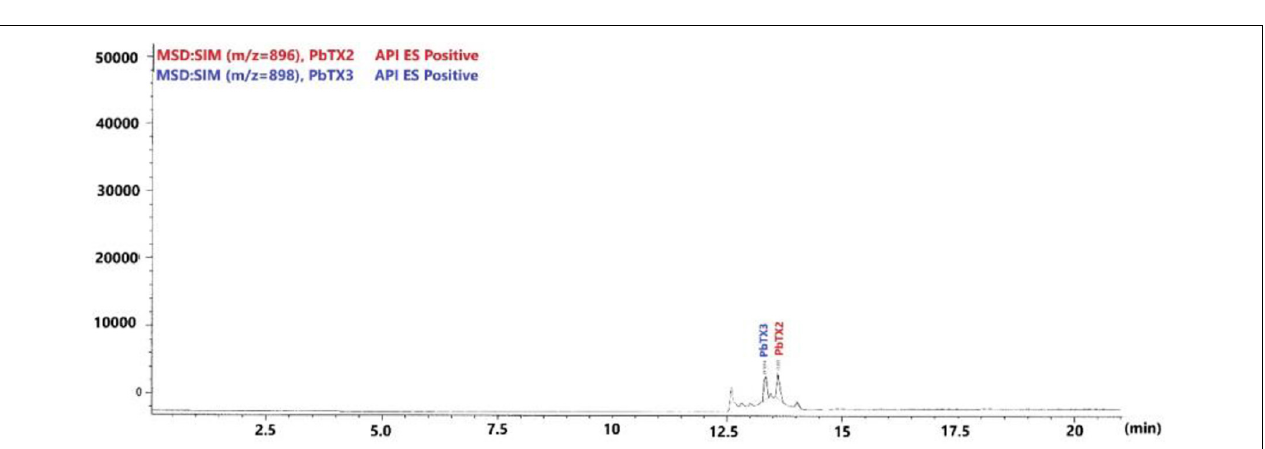
Frontiers in Marine Science |